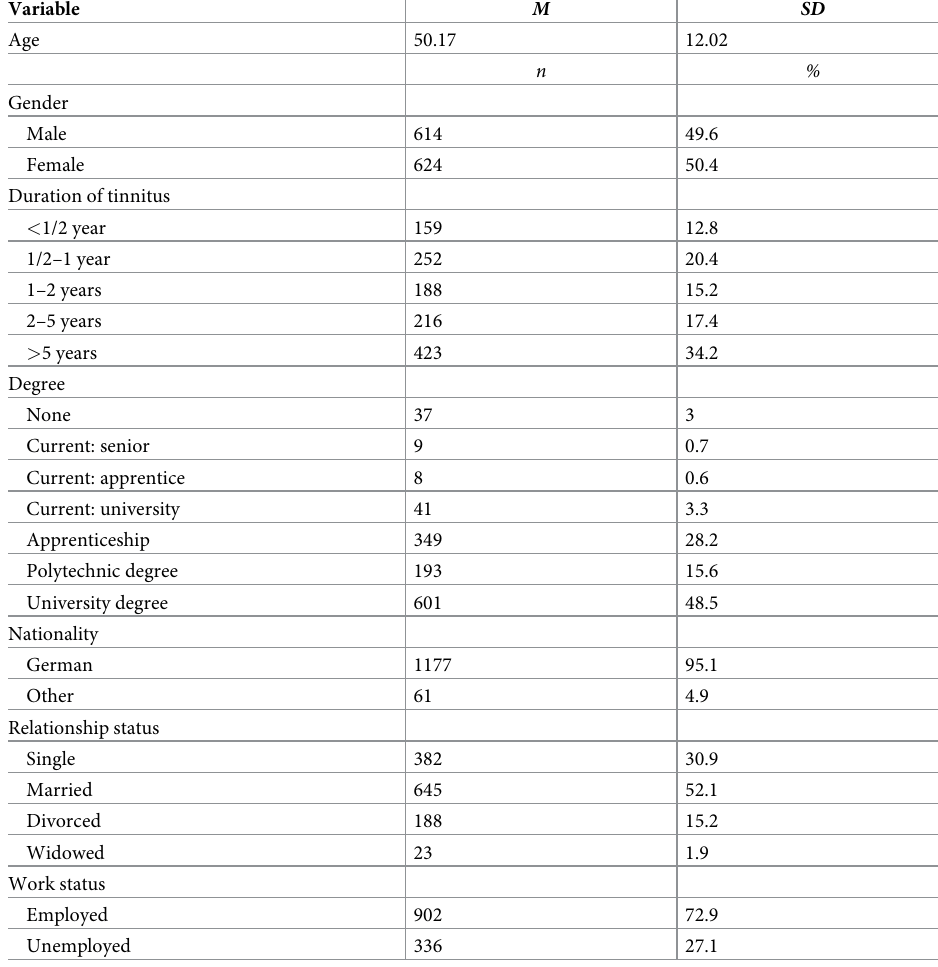
Table 1. Sociodemographic information ( N = 1238 patients with chronic